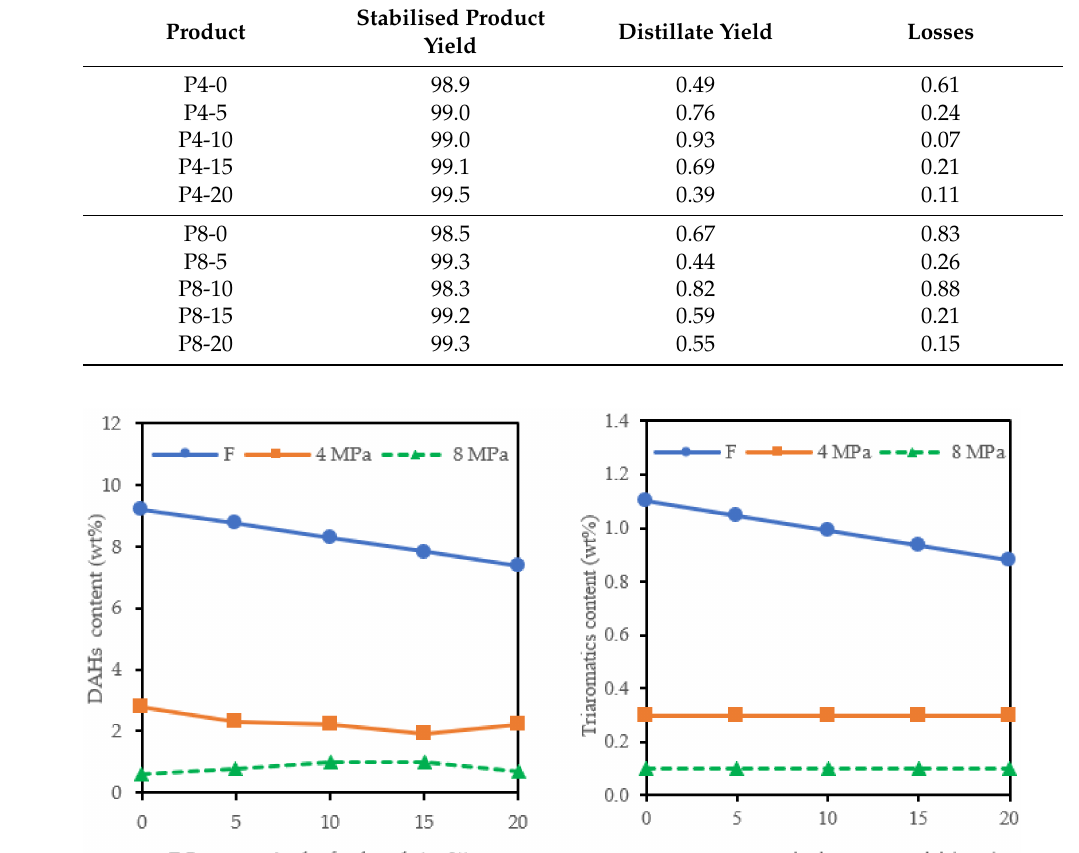
Table 2. The mass balance of the liquid products (cid:48) stabilisation (wt%).